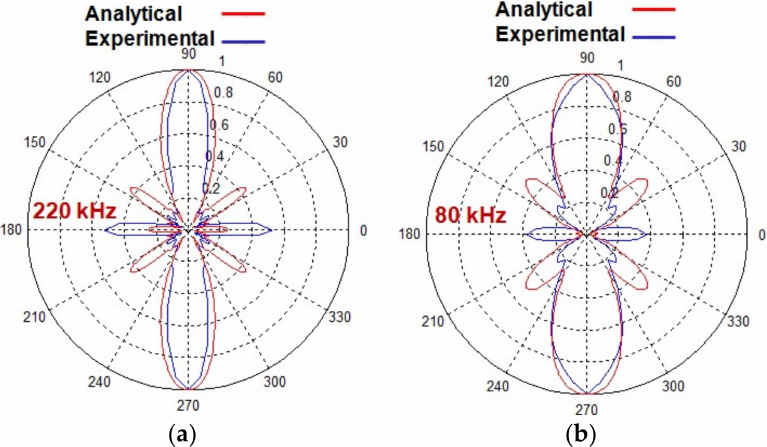
Figure 10. Comparative analysis of normalized directivity patterns of the A0 wave mode obtained by analytical modelling and experimental investigation at 80 kHz, 5-period excitation signal ( a ) and 220 kHz, 5-period excitation signal ( b